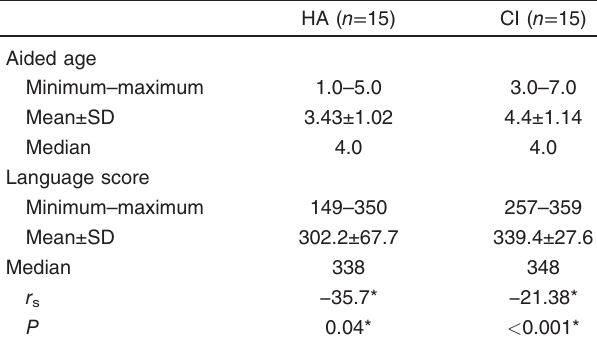
Table 6 Correlation between the aided age and the language score in hearing aids and cochlear implant